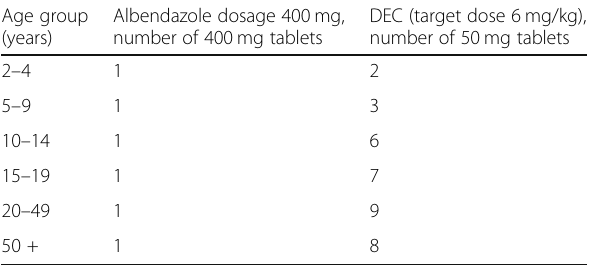
Table 2 Dosage chart used in